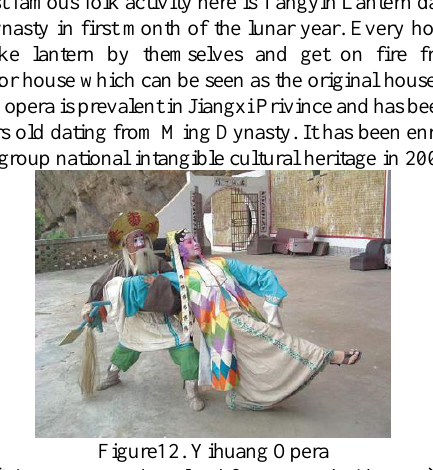
(Picture source:download from